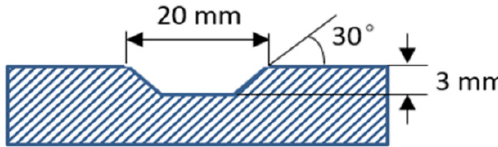
Figure 1. Schematic diagram of a trapezoid groove pre-made on the Inconel 718